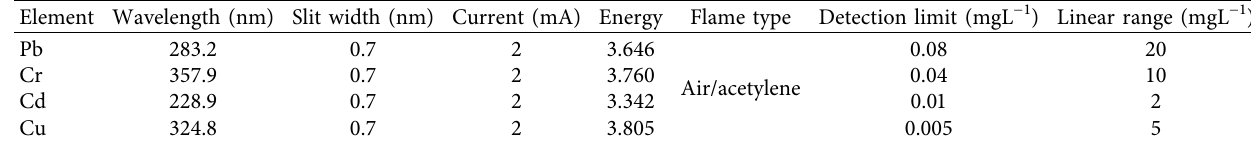
Table 2: Standard operating conditions for the analysis of heavy metals in vegetable samples using FAAS in the study area. Element Wavelength (nm) Slit width (nm) Current (mA)